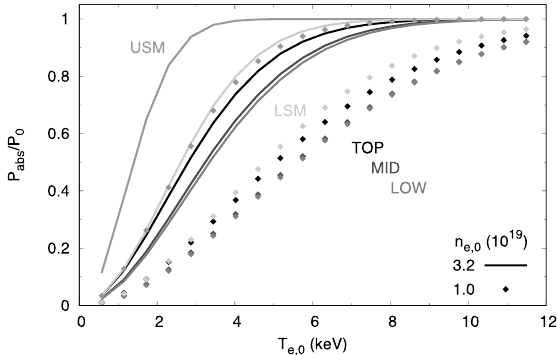
Fig. 5. Absorbed efficiency as a function of T e,0 for different n e,0 scaling; lines correspond to slices at constant n e,0 in Fig.4a,b and equivalent maps for other mirrors.